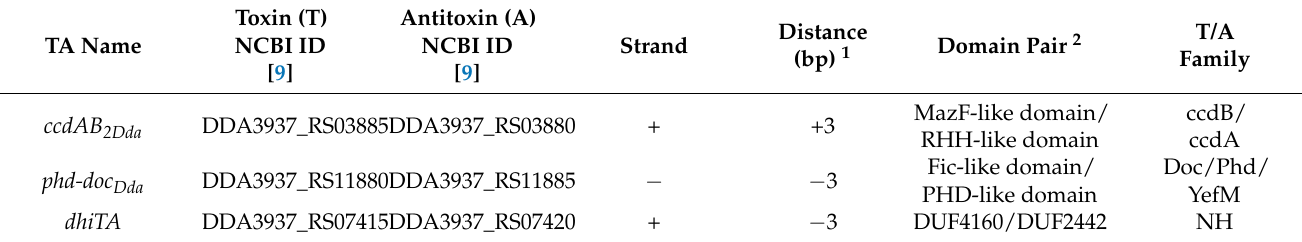
Table 1. Putative type II toxin-antitoxin (TA) systems predicted in D. dadantii